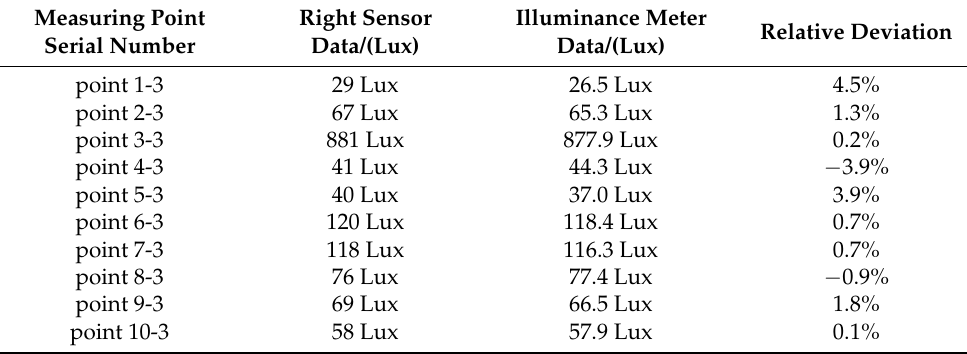
Table 3. Data comparison table of right illuminance sensor and